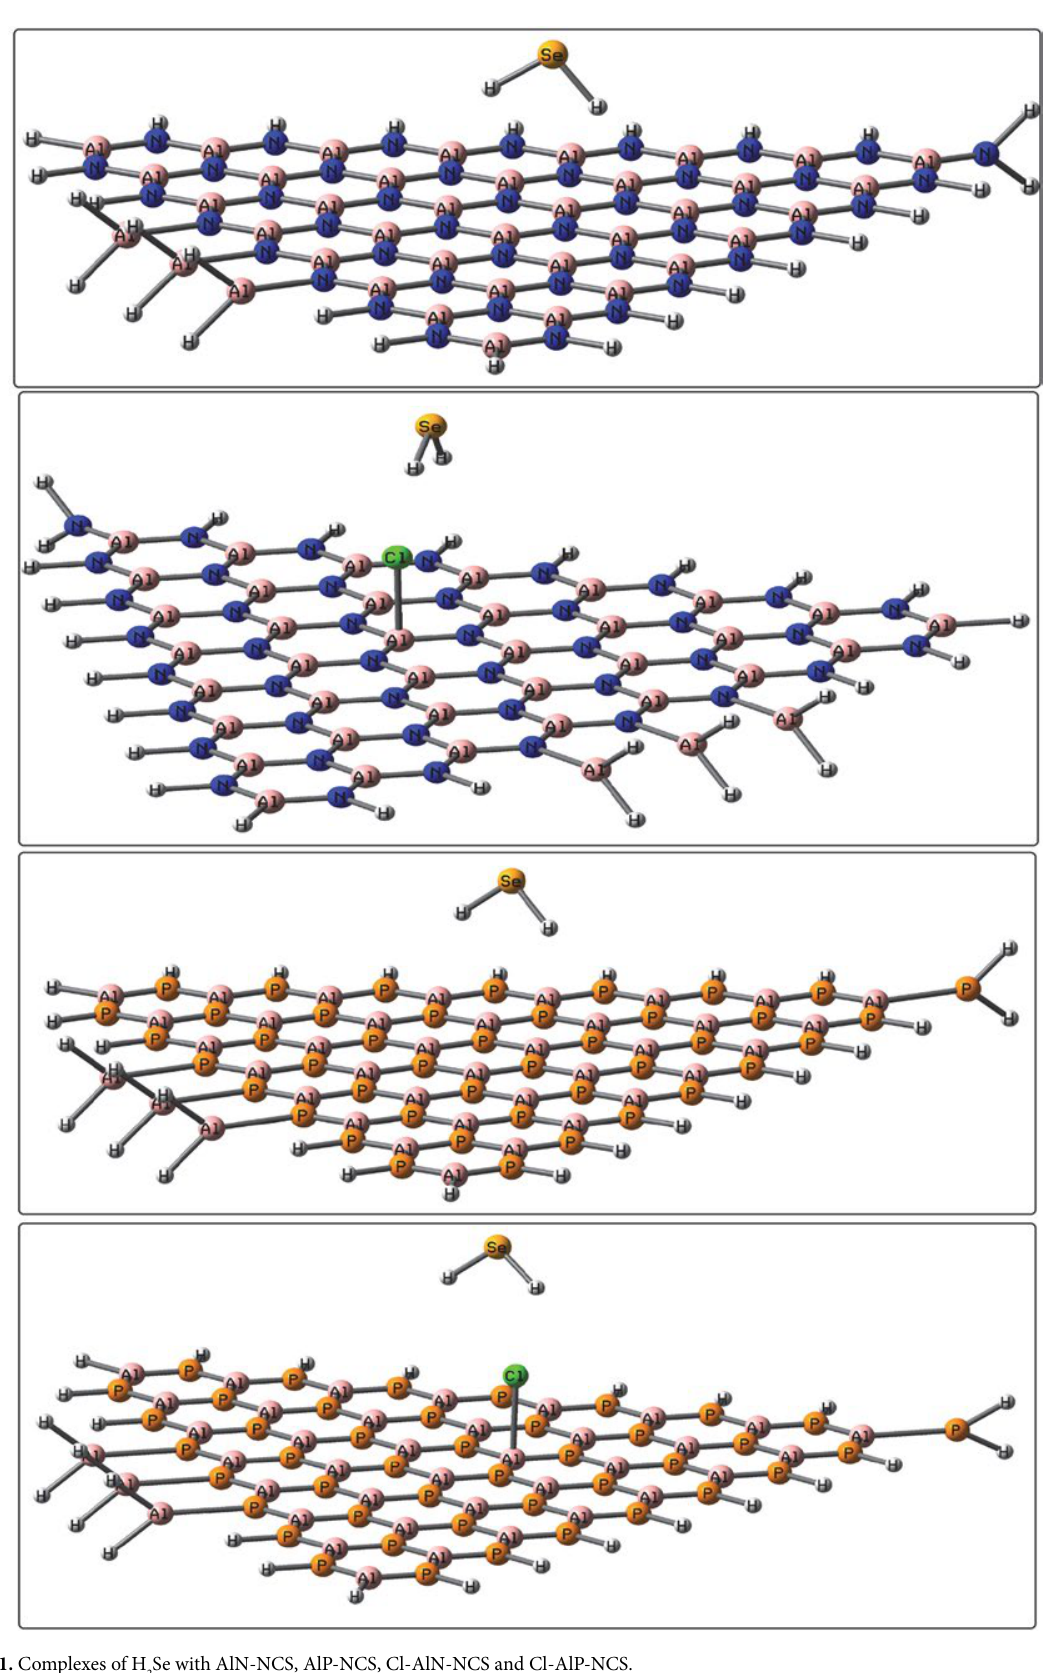
Figure 1. Complexes of H Se with AlN-NCS, AlP-NCS, Cl-AlN-NCS and 2